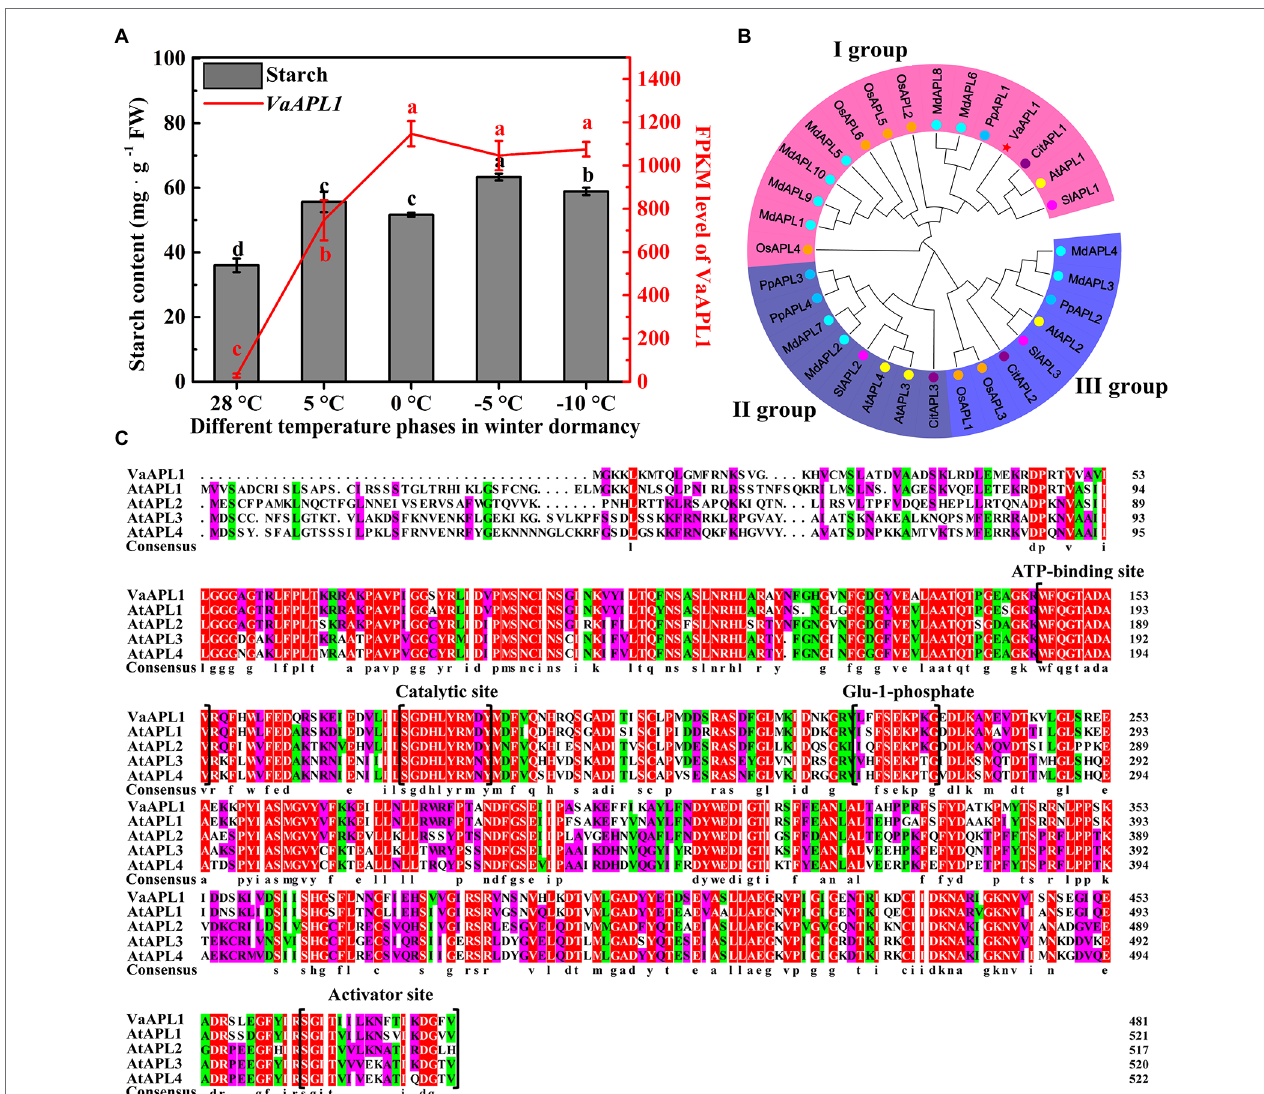
FIGURE 1 | Starch content and VaAPL1 expression in branches phloem of Vitis amurensis under different temperature treatments, APL protein phylogenetic relationship, and multiple sequence alignment of VaAPL1 and AtAPL. (A) Change of starch content and VaAPL1 expression levels in the phloem of V. amurensis at different temperature phases in winter dormancy. (B) Phylogenetic relationship of APL1 proteins from six species. These species included A. thaliana , tomato, rice, peach, apple, and orange. Different colored fan-shaped areas represent different subfamilies. Circles of the same color represent the same species. Red star represents VaAPL1. (C) Multiple sequence alignment between VaAPL1 and AtAPL